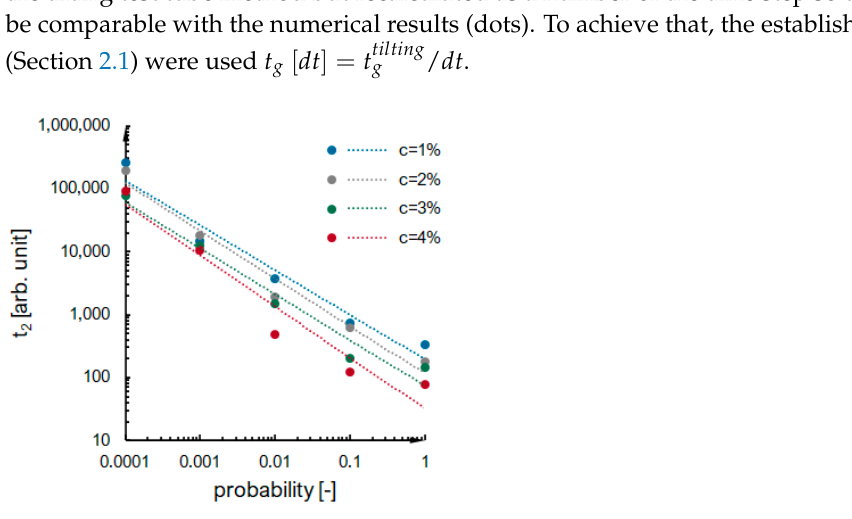
Figure 11. The dependence of the second phase duration on effective collision probability for variable concentrations of secondary particles in a system.